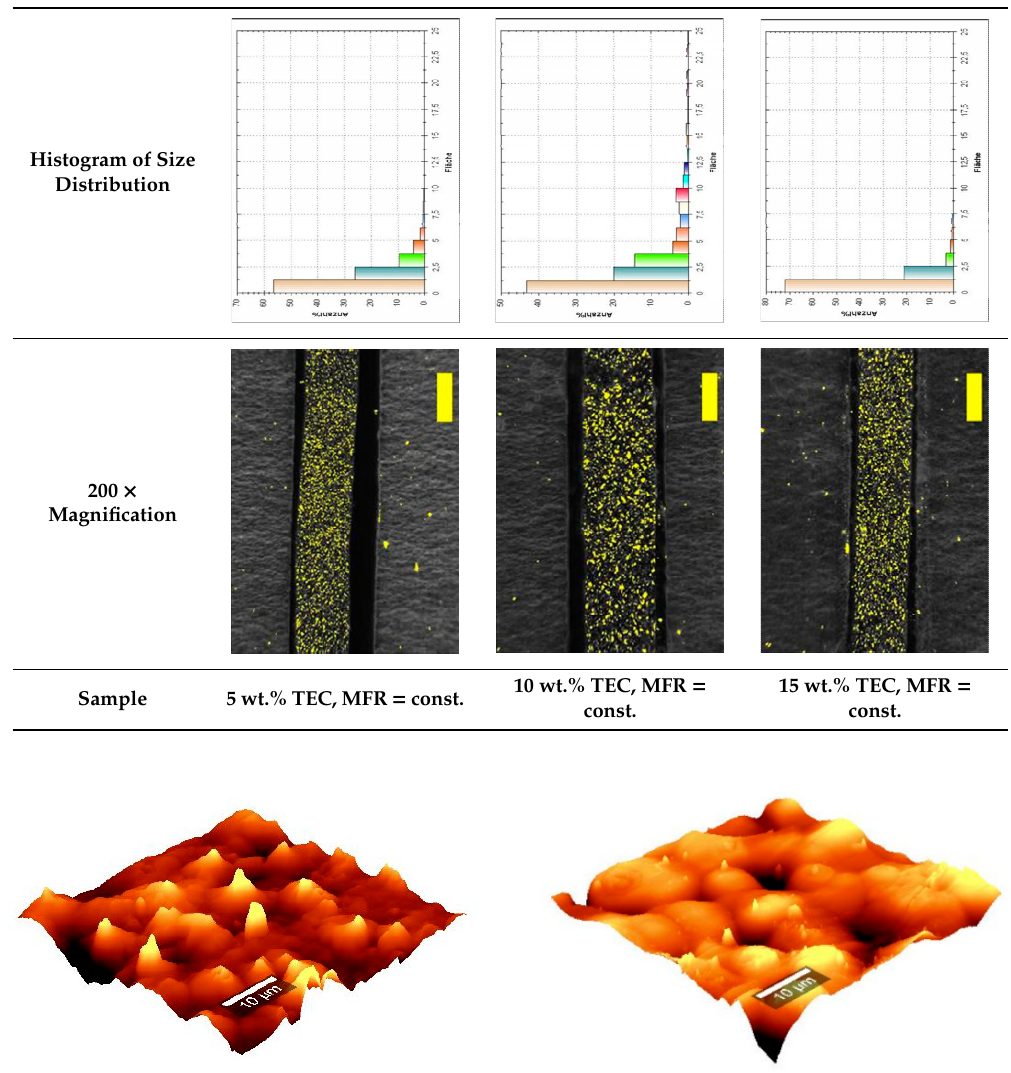
Figure 17. Atomic force microscopy (AFM) measurements of PHBV film with 15 wt.% PEG. left , extrusion temperature: 176 °C (MFR = const.); right , extrusion temperature: 185 °C (T = const.).